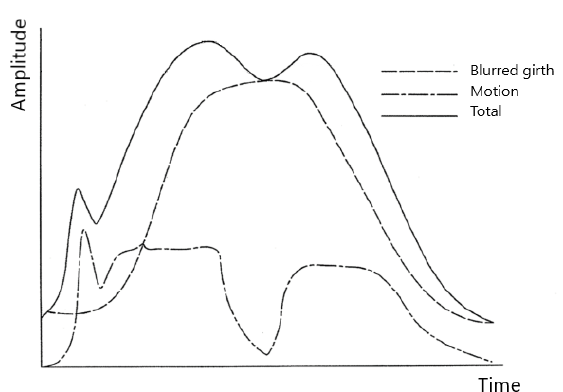
Figure 3. Influence of knit motion and acceleration artefacts (blurred girth) on the breath signal read by the Airgo ™ band (modified from patent number US201462007142P).